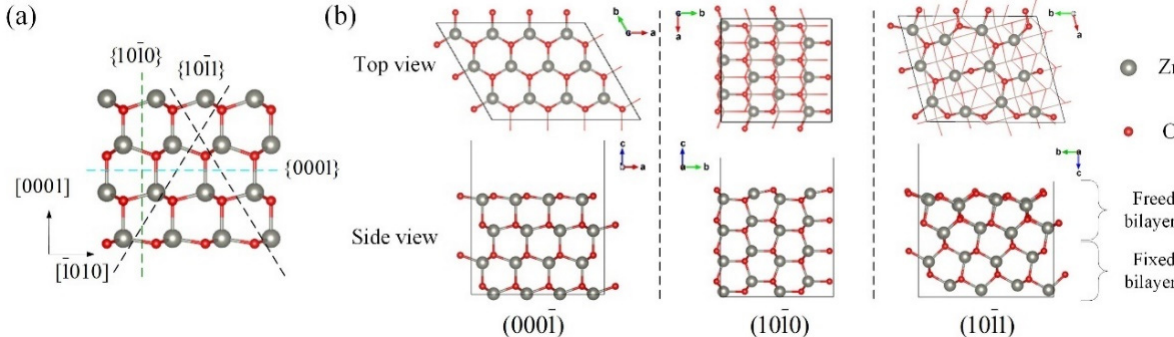
Figure 1. The studied facets, their positions and correspondingly relaxed slabs. (a) Atomic model of wurtzite ZnO projected along [1210] , showing {1011} , {0001} and {1010} facets. (b) The relaxed slabs of ZnO(0001) , ZnO(1010) and ZnO(1011) , respectively. Vacuum layers were set along c axes. Explicitly, in the top view, all bilayers except the first bilayer are shown with a